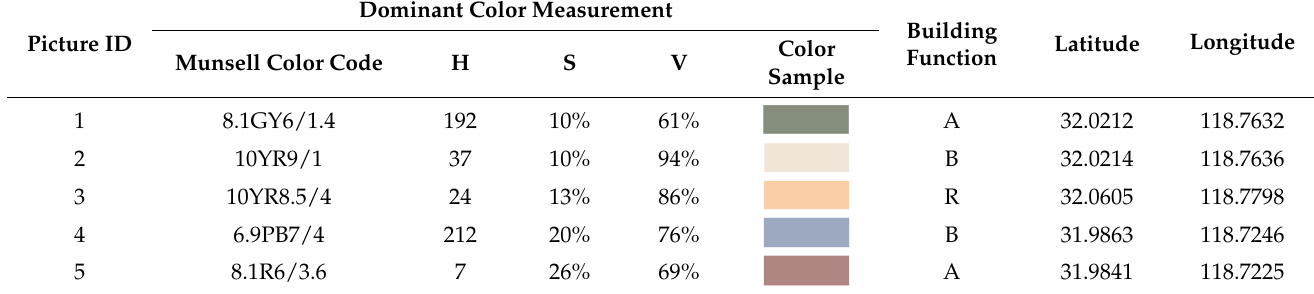
Table 7. The data structure of façade color measurement and building classification results. The Munsell color system divides hues into ten kinds of colors: red (R), red-purple (R.P.), purple (P), purple-blue (P.B.), blue (B), blue-green (B.G.), green (G), green-yellow (G.Y.), yellow (Y), and yellow-red (Y.R.). Dominant Color Picture ID